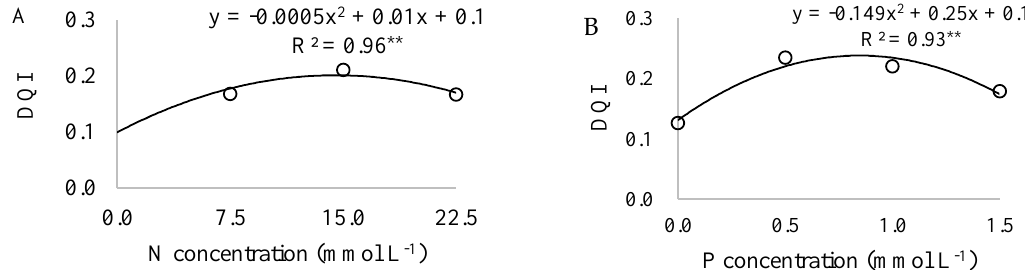
Figure 5. Dickson quality index (DQI) as a function of nitrogen (N) ( A ) and phosphorous (P) ( B ) concentrations in the nutrient solution of Eucalyptus spp. clonal rooted cuttings, ** significant at 1% probability using the F-test.